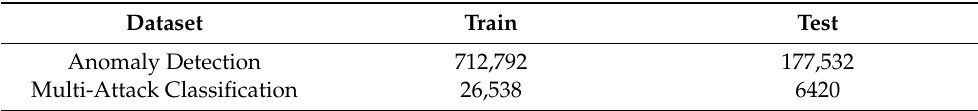
Table 3. Training and test datasets for both anomaly detection and multi-attack classification after